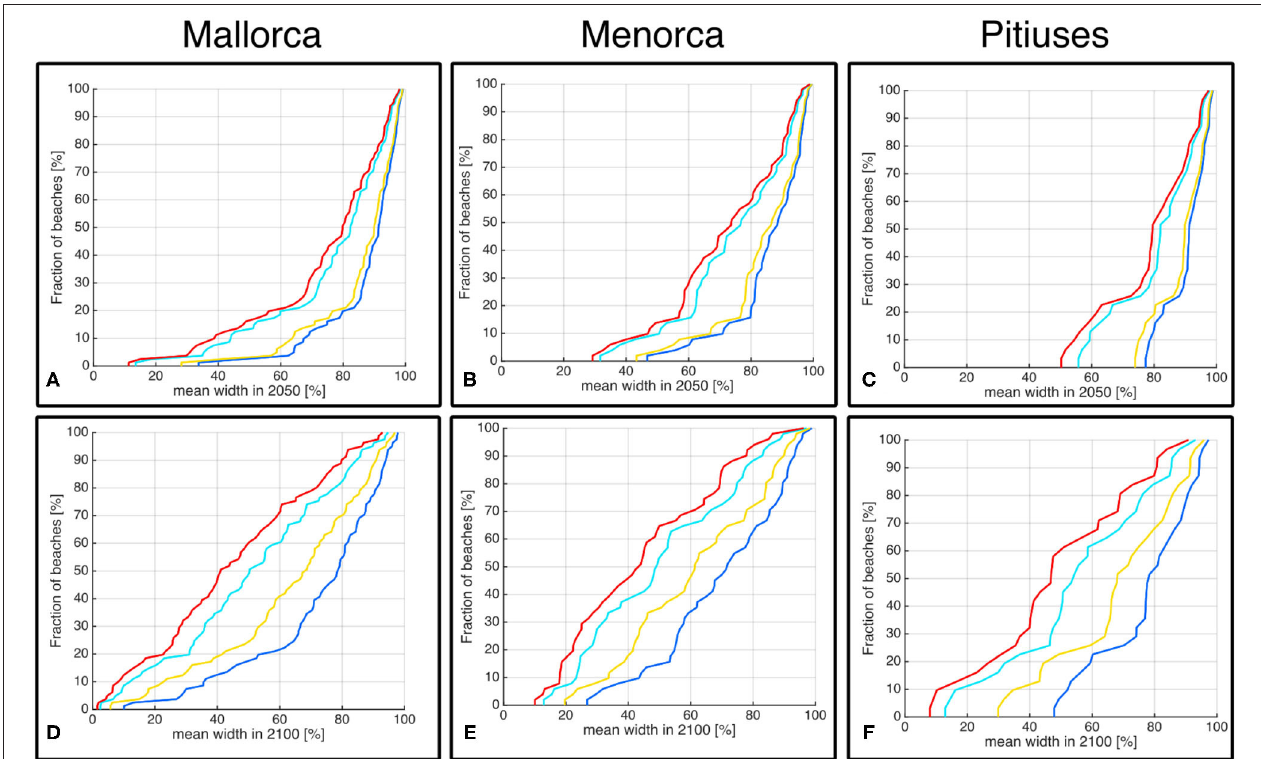
FIGURE 7 | Cumulative density functions (CDF) of beach relative mean width (referred to nowadays width), computed from the time averaged mean evolutions of each beach according to the MSL forcing of the RCP4.5 and RCP8.5 scenarios (lower and upper bounds). Each panel line corresponds to a MSL evolution, using the color code presented in Figure 2 . (A–C) Use data extracted from year 2050, and (D–F) Use data from 2100. CDFs are computed for beaches of Mallorca (A,D) , Menorca (B,E) and the Pitiüses (C,F) .